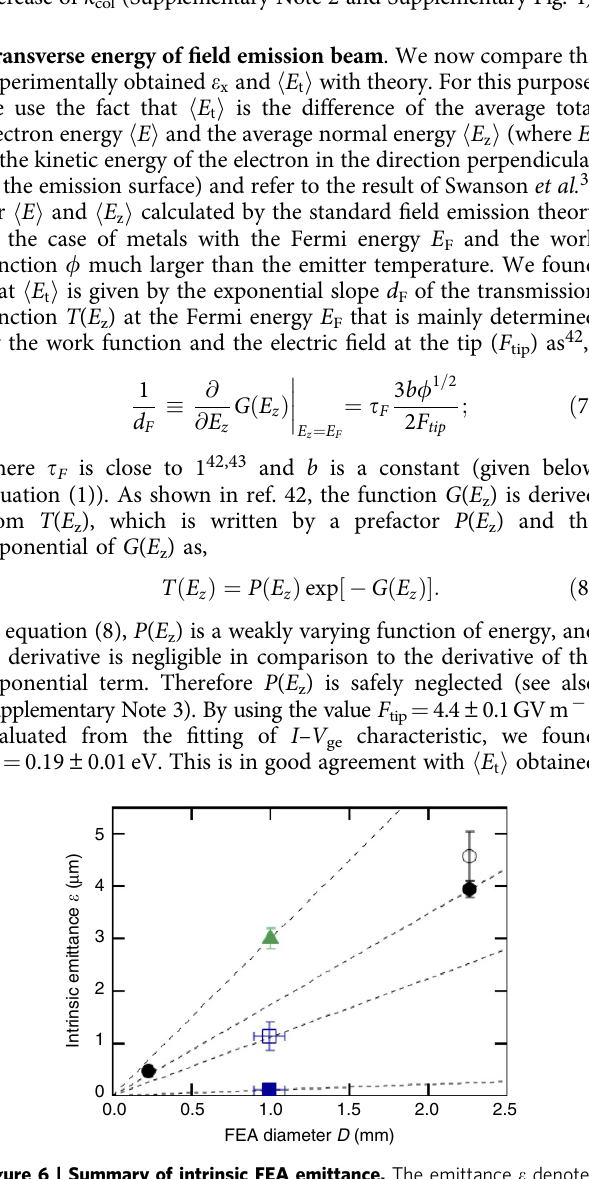
Figure 6 | Summary of intrinsic FEA emittance. The emittance e denotes normalized r.m.s. 44 values. The filled square ( k col ¼ 1) and the empty square ( k col ¼ 0) are the present double-gate FEA results. The intrinsic emittance values of single-gate FEAs are also shown. The circles show e of single-gate FEA with molded nanotips fabricated as the double-gate FEA in the present report. The data denoted by filled circles were measured by solenoid scan and the error bar indicates the r.m.s. fitting uncertainty, see ref. 5. The value denoted by empty circle was measured by inserting a single slit mask 40 and the error bar indicates the r.m.s. uncertainty of the evaluation of the beam divergence. The triangle is the result of a Spindt FEA reported in ref. 40 by solenoid scan. The lines are guide for the eye: representing e ¼ x D , with x equal to 0.1, 1.1, 1.7 and